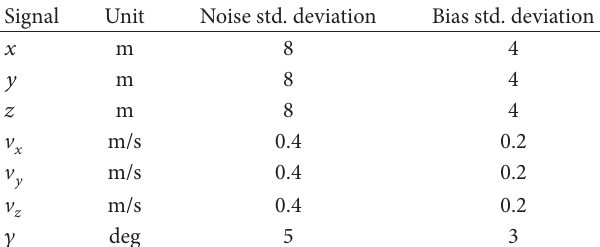
Table 3: Signal noise and bias standard